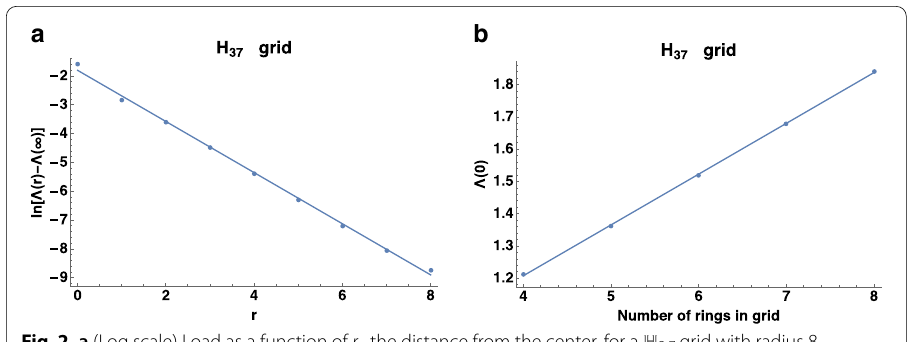
Fig. 2 a (Log scale) Load as a function of r , the distance from the center, for a H 3,7 grid with radius